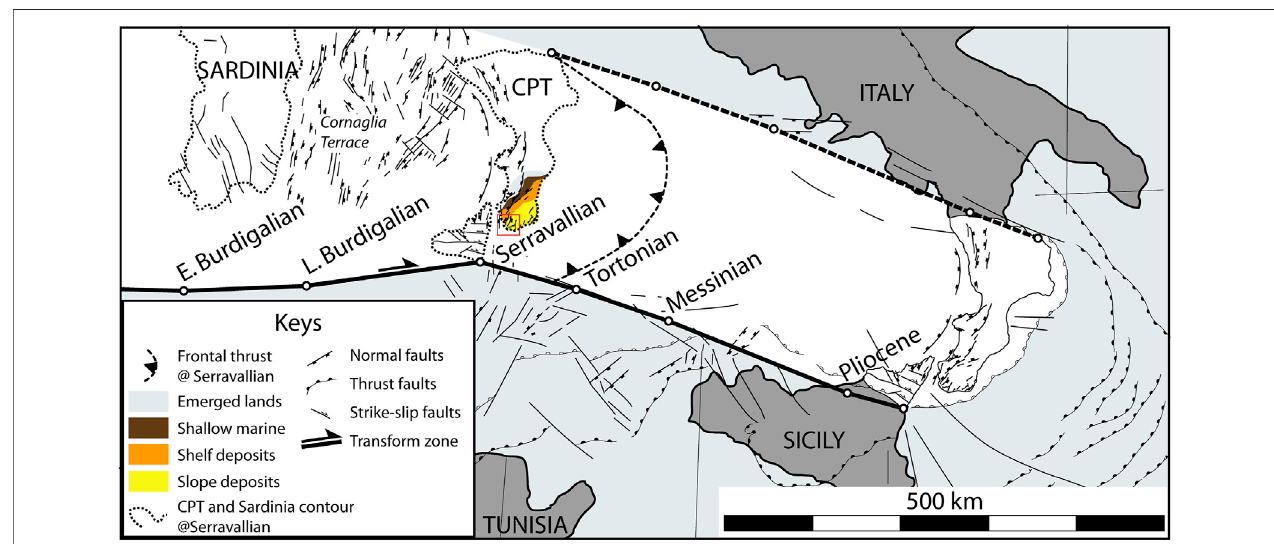
FIGURE 1 | Paleogeographic reconstruction ofthe MottaSan Giovanni Formation during the early Serravallian. Relative position of Sardinia and CPT compared to Italy, Sicily, and Tunisia considered fi xe (Gray) based on the reconstruction for the kinematic complex D2 of Vitale and Ciarcia (2013). Relative position of CPT and migrationpath fromVitaleandCiarcia(2013).FaultpatternisfromLeprêtre etal.(2019)andJolivetetal.(2021) andreferenceherein.FaultpatterninCPTisre fi nedusing Kezirian et al. (1994) (Sicily) and Brutto et al. (2018) (Calabria). Depositional environments are from the synthesis of Raber (2003) and reference herein. Red square illustrates the studied